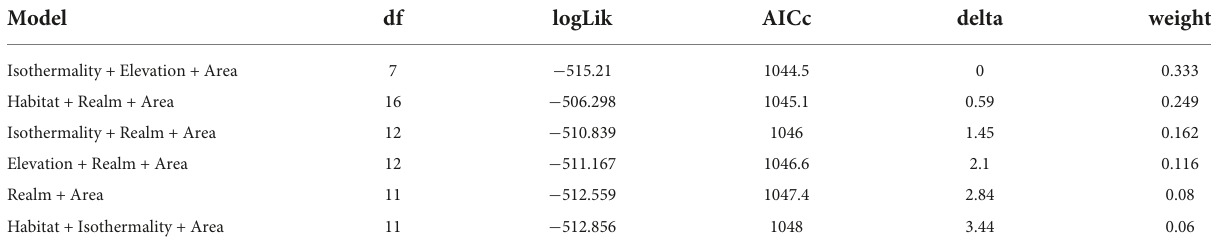
TABLE 1 The six models relating amphibians range shift and biological and biogeographical traits with the highest rankings among the 130 candidate models and their second-order Akaike information criterion values (AICc), AICc weights (weight), AICc differences (delta), Log-likelihood (loglik), and degrees of freedom